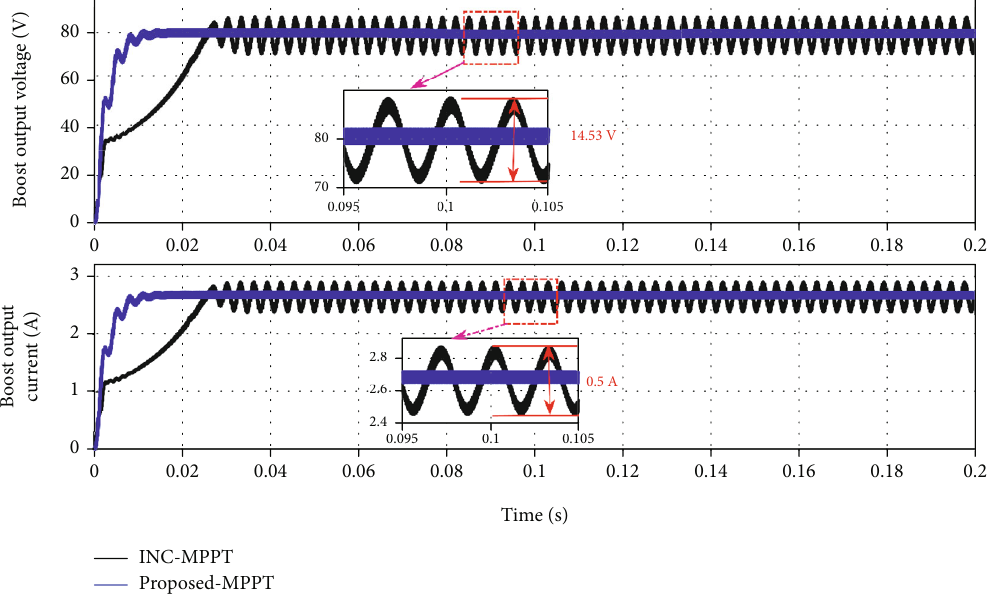
Figure 9: Simulation results of the output current and voltage of the boost converter under